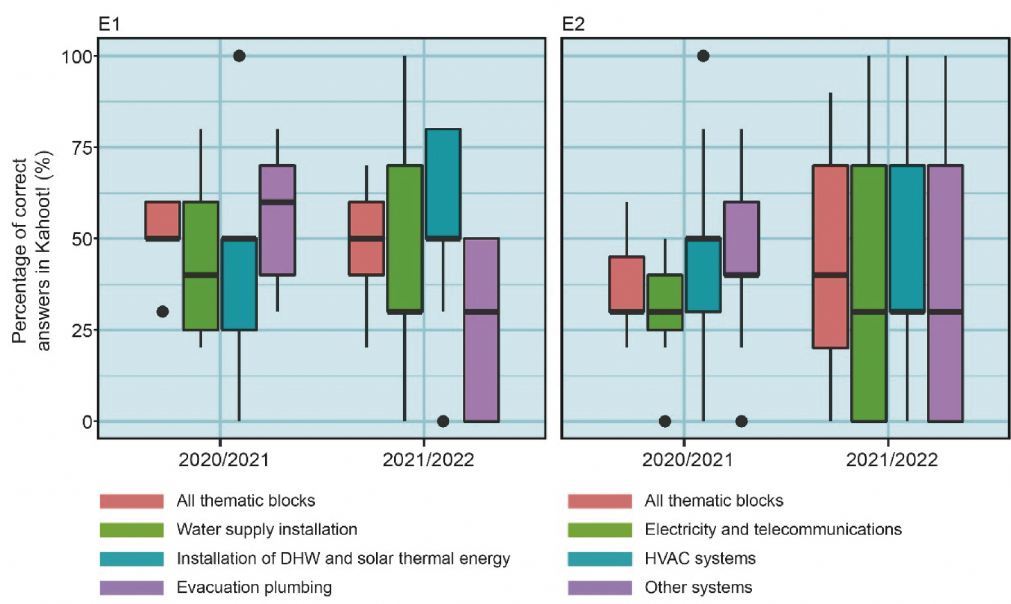
Figure 1. Percentage of correct answers in each thematic block in Kahoot! sessions